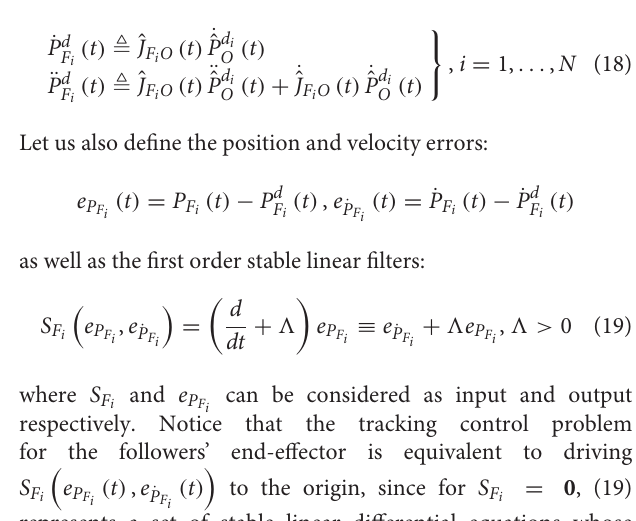
the estimation errors to zero. Additionally, the transient response depends on the convergence rate of the performance functions ρ i ( t ) , j = 1, . . . , 6 and i = 1, . . . , N that is directly affected by j the parameter λ